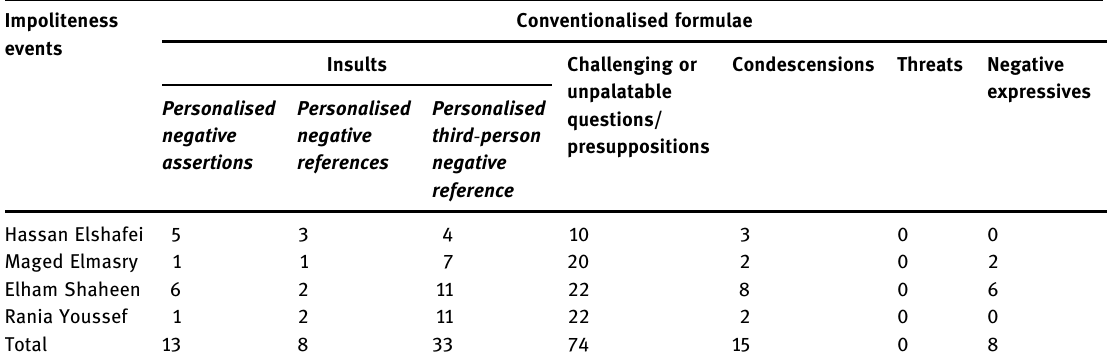
Table 2: Frequencies of conventionalised formulae Impoliteness